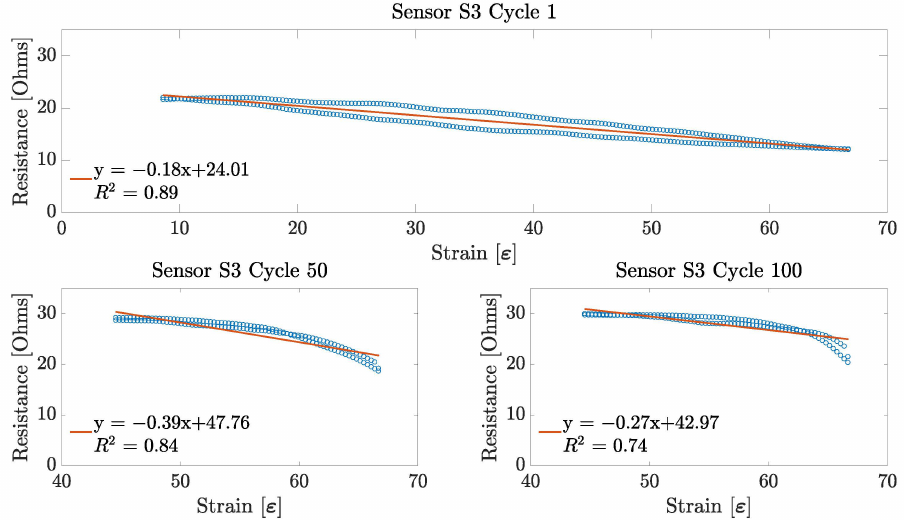
Figure 14. Linearity results for Sensor S3. Linearity data from Cycle 1 is shown over a 7.5–66% work- ing range, whereas linearity data from Cycles 50 and 100 are shown over a 40–66% working